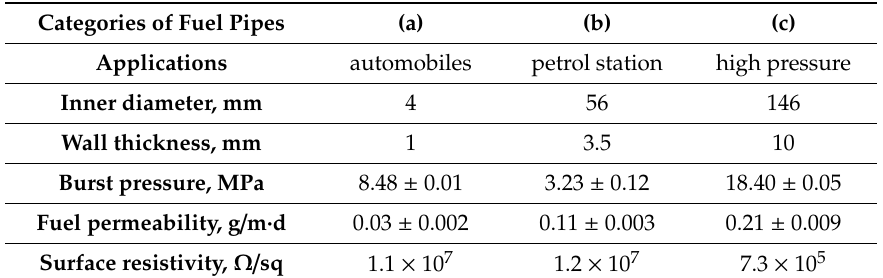
Table 4. The basic properties of three kinds of fuel